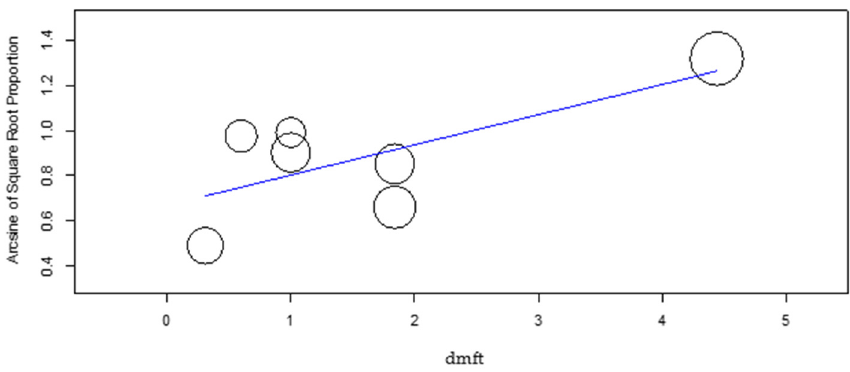
Figure 8. Meta-regression of dmft versus caries incidence for the DS group.